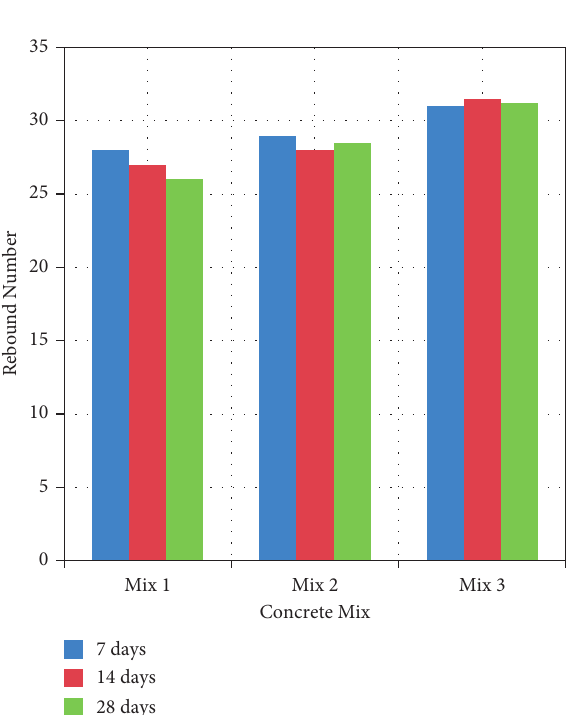
Figure 4: Rebound number for different proportions of